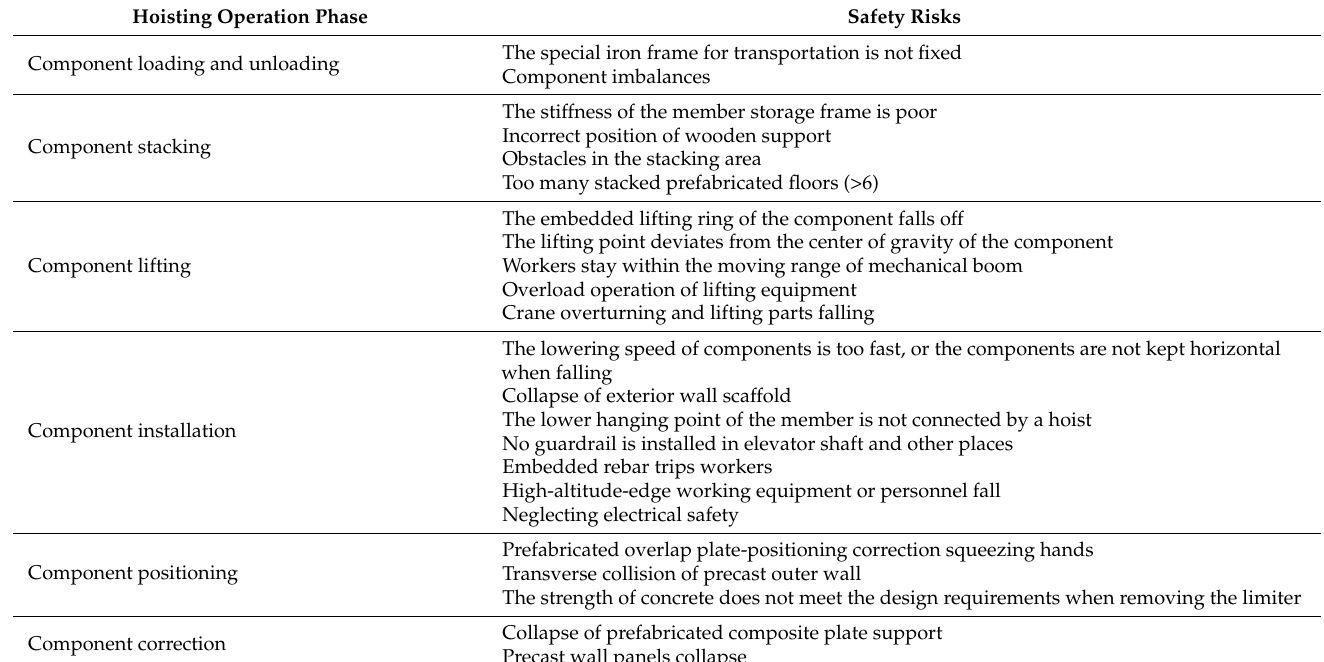
Table 5. Identification of safety risks in hoisting operations of prefabricated